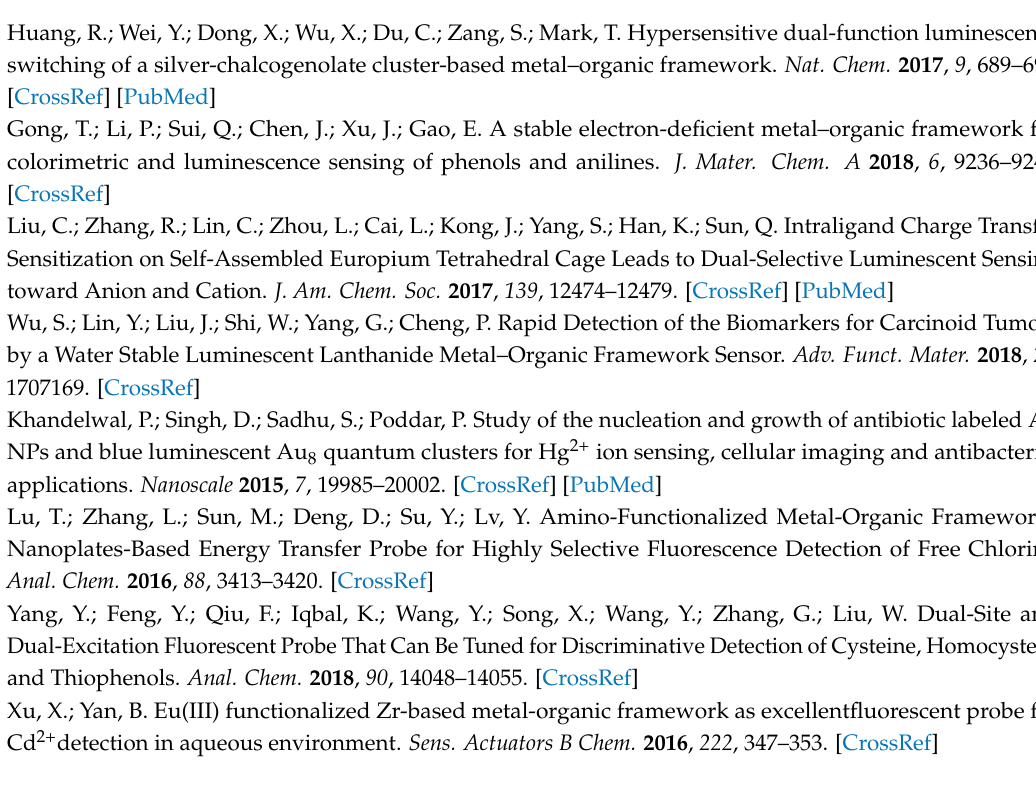
Scheme S1: The structure of the ligand H3dcpcpt. Figure S1: PXRD patterns of complex 3 simulated from the X-ray single-crystal structure and as-synthesized samples of complexes 1 – 4 , Figure S2: ( a ) The asymmetric unit of complex 3 . All hydrogen atoms and solvent molecules are omitted. ( b ) Coordination polyhedrons of Tb 3+ ion, Figure S3: FT-IR spectra of ligand and complexes 1 – 4 , Figure S4: TG curves of complexes 1 – 4 , Figure S5: UV-vis spectra of ligand and complexes 1 – 4 , Figure S6: Emission spectra of antibiotics@ 4 excited at 320 nm, Figure S7: Stern-Volmer plot of TC@ 4 , NZF@ 4 , NFT@ 4 , SDZ@ 4 and CBZ@ 4 antibiotics@ 4 , Figure S8: Stern-Volmer plot of MDZ@ 4 , DTZ@ 4 and ODZ@ 4 , Figure S9: FT-IR patterns of complex 4 before and after sensing antibiotics, Figure S10: PXRD patterns of complex 4 before and after sensing SDZ and CBZ. Table S1: Elemental analysis of lanthanide ions by ICP for complex 4 , Table S2: Luminescence lifetime of complexes 1 – 4 , Table S3: Peak analysis for 4 , Table S4: Peak analysis for TC@ 4